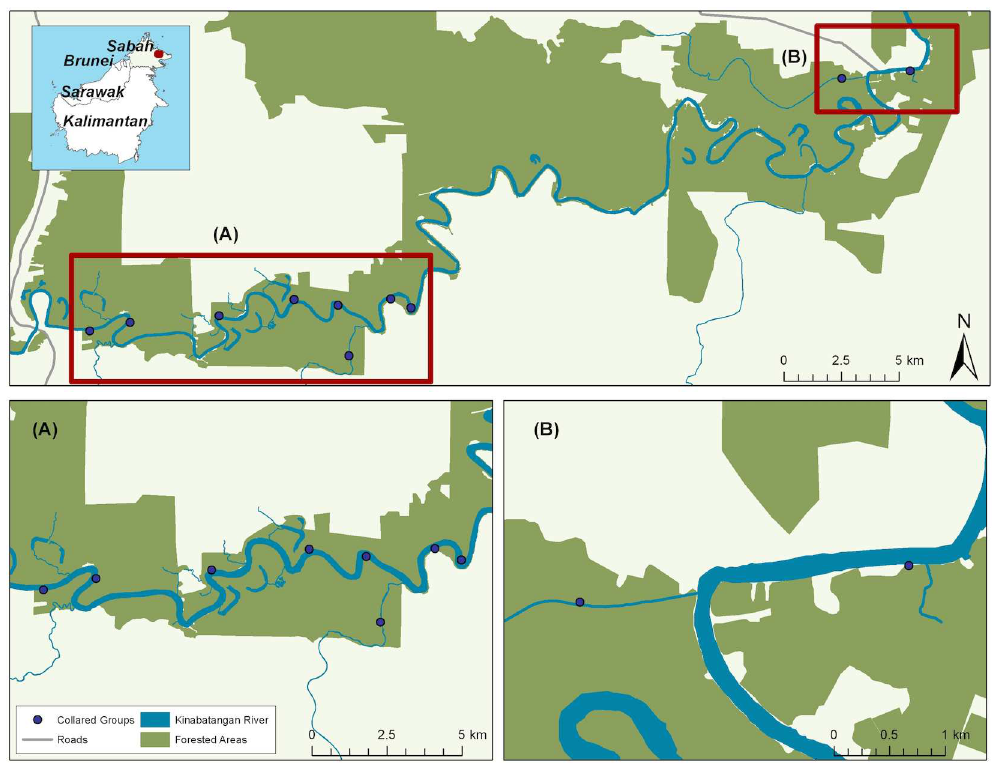
Fig 1. Collaring sites of 10 proboscis monkeys along the Kinabatangan River, Sabah, Malaysia.